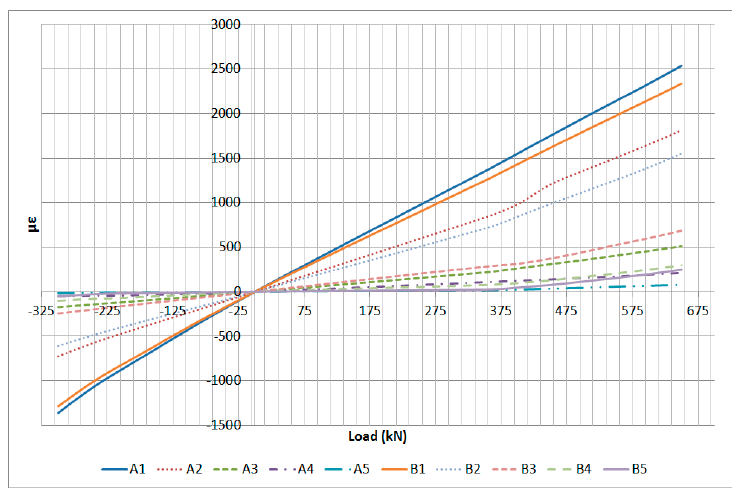
Figure 16. Specimen 1- FBGs embedded on stringer foot-tensile & compression after fatigue.